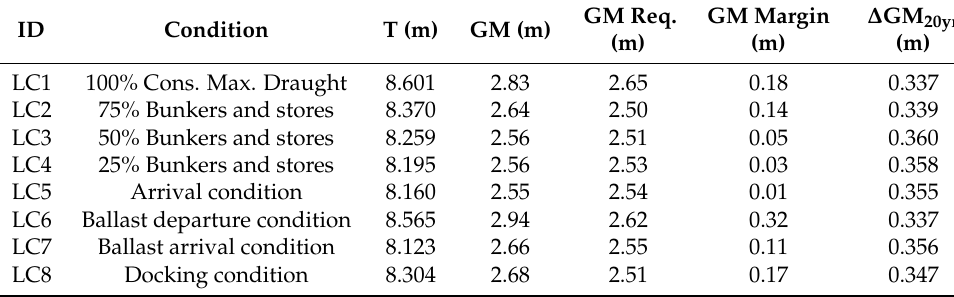
Table 6. Loading conditions and GM margins for cruise ship C1 with the original layout.